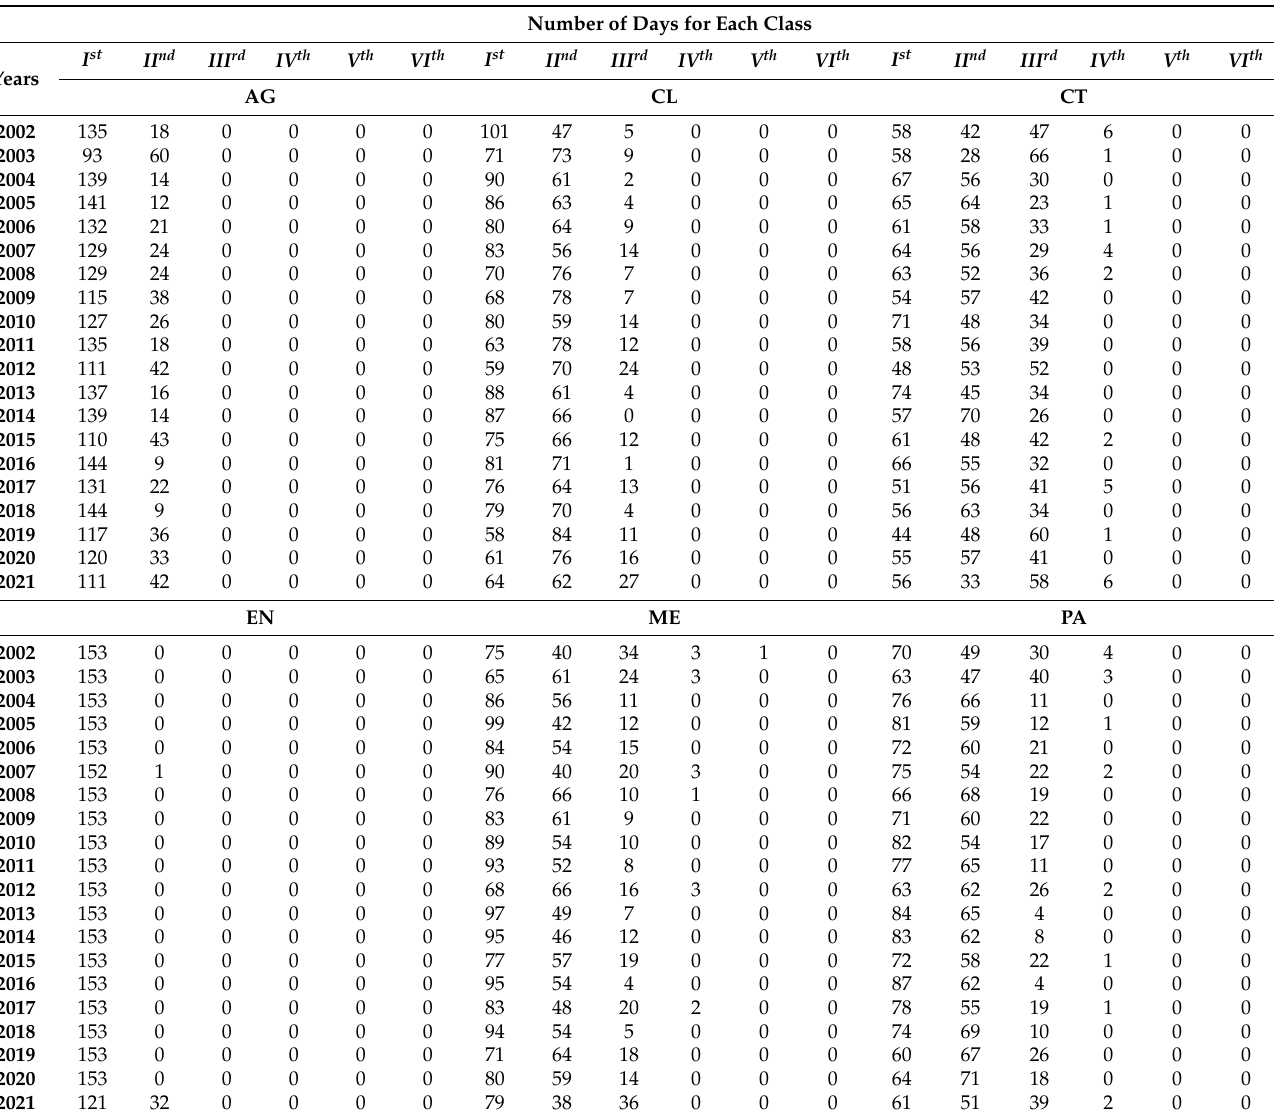
Table A1. Annual distribution of the number of days in each TDI class for the provinces of AG, CL, CT, EN, ME, and